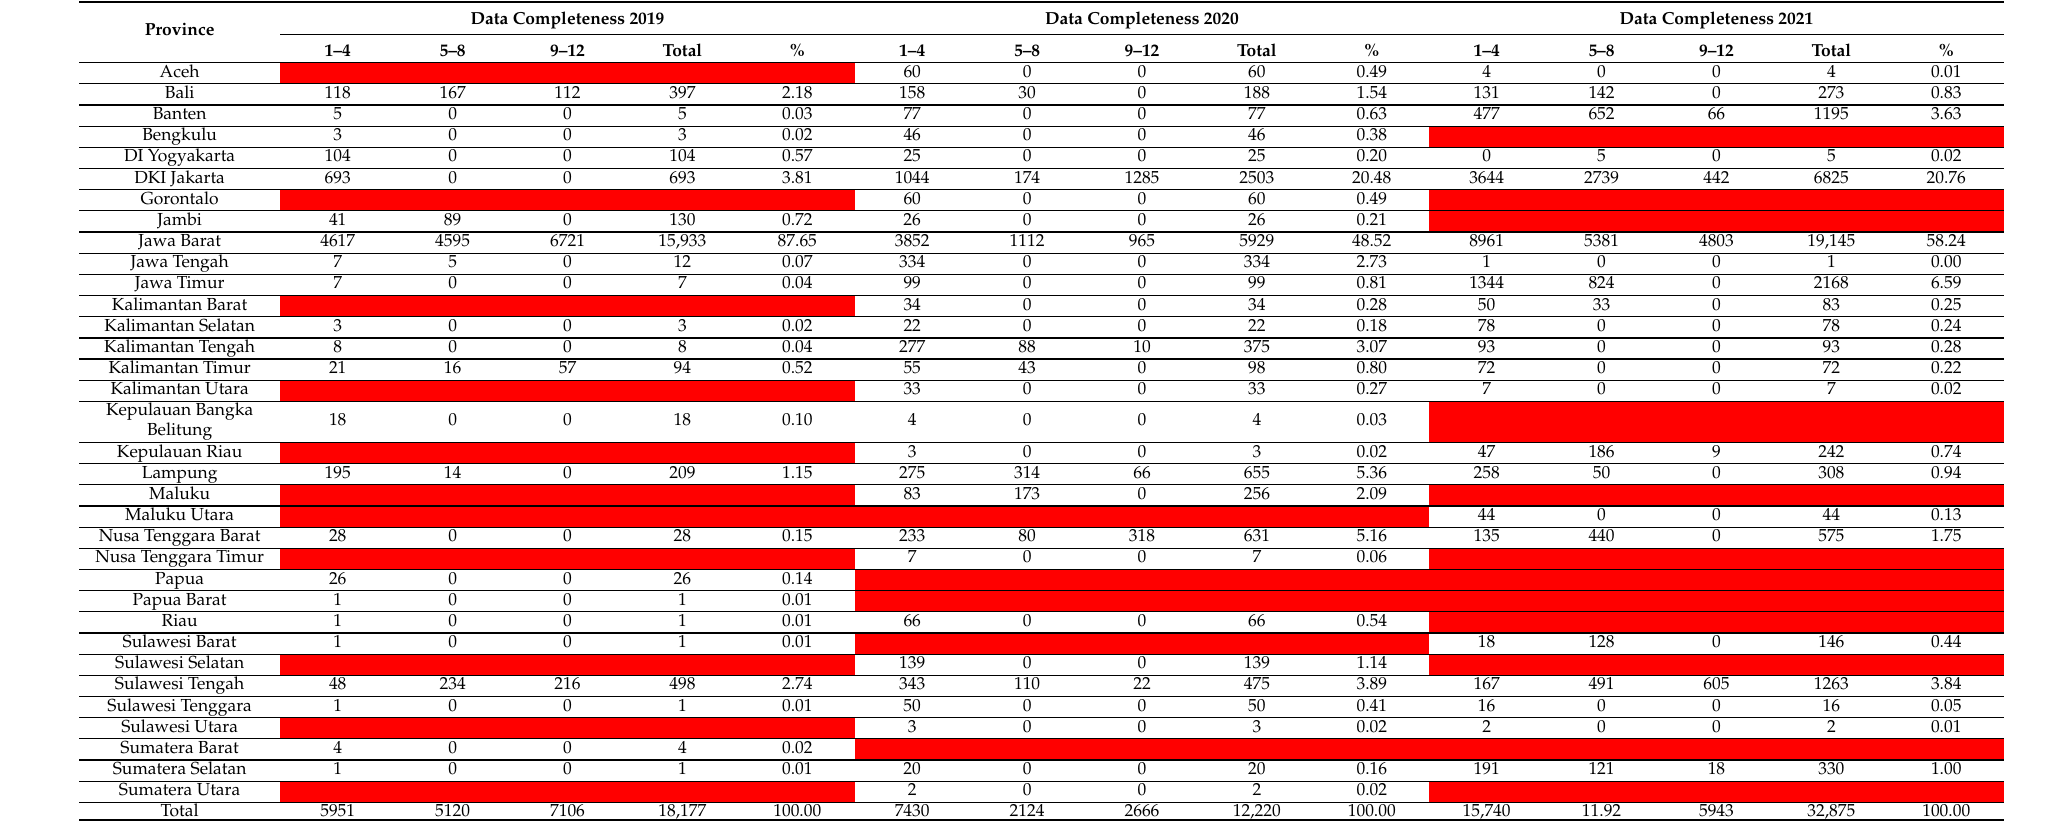
Red: Highlight for no data